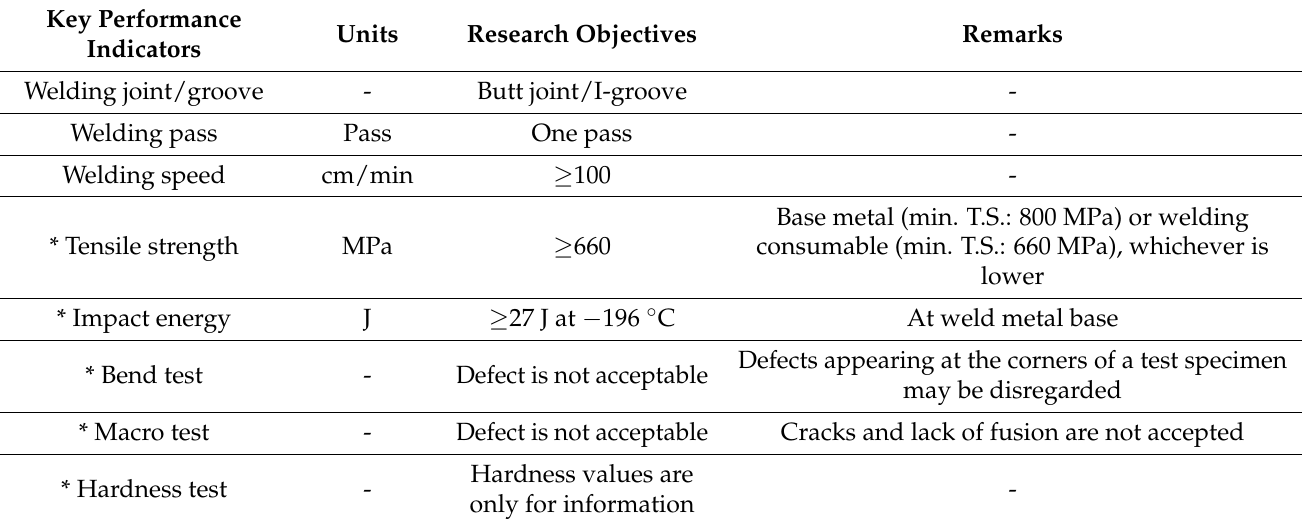
Table 2. Research objectives and IGC Code requirements.